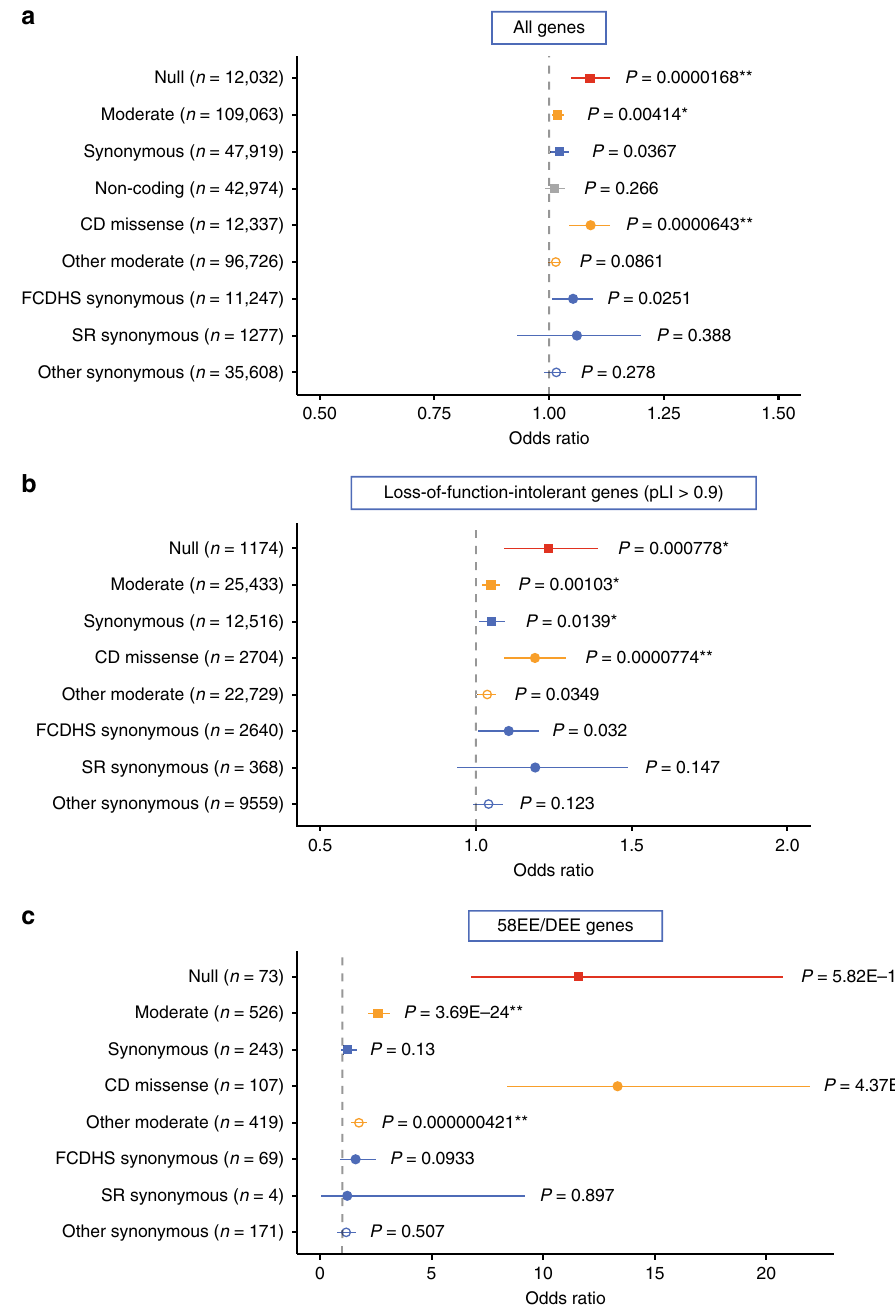
Fig. 1 Patterns of excess of URVs in EE/DEE. a Result of logistic regression analysis testing association between each type of URVs and the case − control status. Odds ratios for one additional URV and 95% con fi dence intervals are plotted (i.e. one additional URV changes the risk of being EE/DEE with the indicated odds ratio). Uncorrected P values for each test are shown beside the plots. Plots are color-coded as follows: null, red; Moderate (de fi ned by SnpEff 17 , e.g. missense and in fl ame), orange; synonymous, blue; noncoding, gray; and shape-coded as follows: overall functional type with no subclassi fi cation (e.g. null and Moderate), fi lled square; URVs more likely to be functional (i.e. consensus-damaging (CD) missense and frontal cortex DNase I hypersensitive site (FCDHS) and splice region (SR) synonymous), fi lled circle; URVs less likely to be functional, open circle. The numbers of URVs subjected to each analysis are indicated in the brackets. b , c Results of logistic regression analysis focusing on LOF-intolerant genes (probability of being LOF-intolerant (pLI)>0.9) ( b ) and known 58EE/DEE genes (Supplementary Table 3) ( c ), respectively. Statistically signi fi cant results considering the total number of hypotheses tested in Figs. 1 and 2 ( n = 66) are indicated as follows: **Bonferroni-corrected P <0.05 (raw P <0.000758), *Benjamini − Hochberg-corrected P <0.05 (raw P